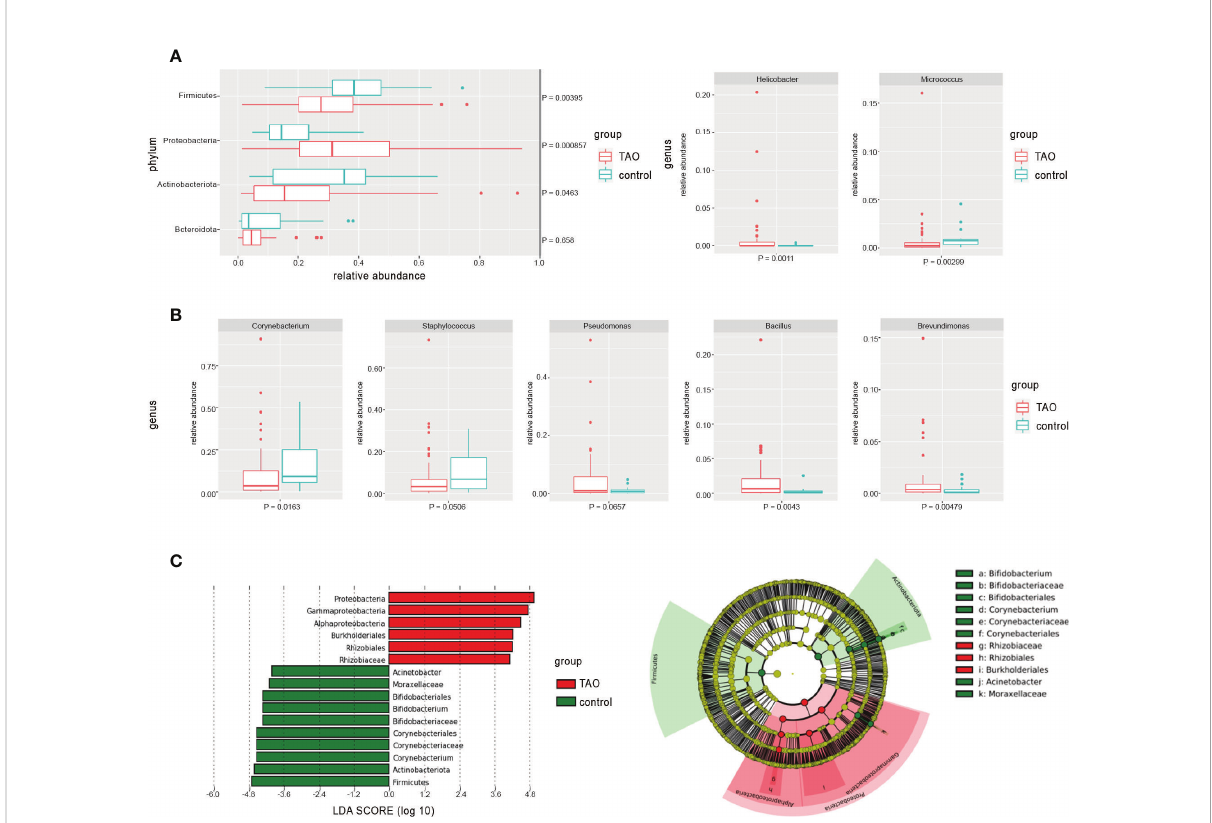
FIGURE 2 The differences in average relative abundance of dominant bacteria at (A) the phylum level and (B) the genus level (mean relative abundance > 0.50%) were assessed by the Wilcoxon rank-sum test. (C) Linear discriminant analysis was used to verify with signi fi cant differences between groups (cutoff =